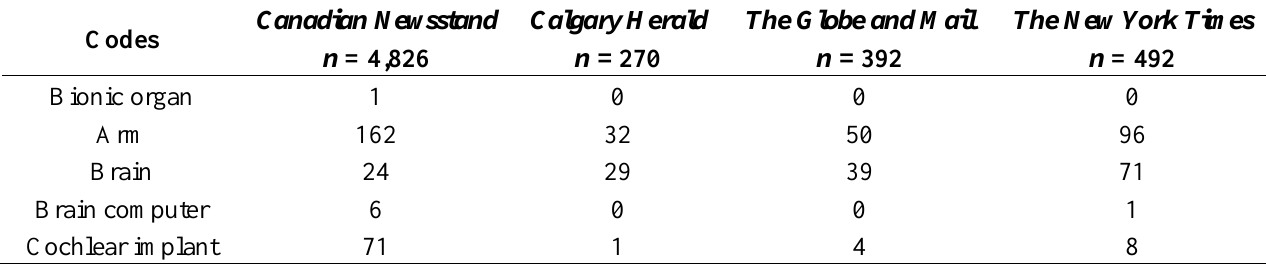
Table 2. Bionic and related products mentioned in the